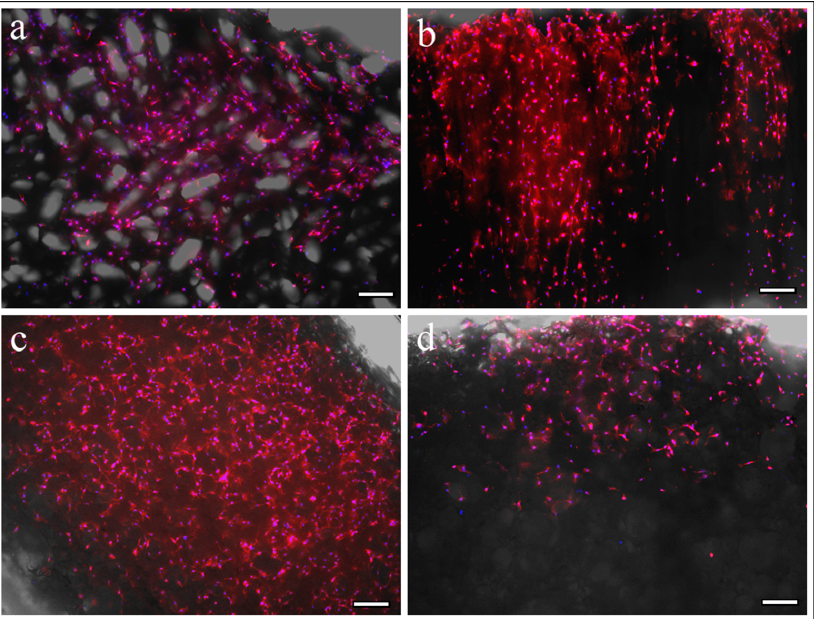
Figure 5. A merge of fluorescent images and bright field images. MC3T3-E1 cells attached onto ( a , c ) the upper base and ( b , d ) the cross-sectional plane perpendicular to the upper base of ( a , b ) UDPHAp and ( c , d ) IP-CHA. White bars represent 200 µm.